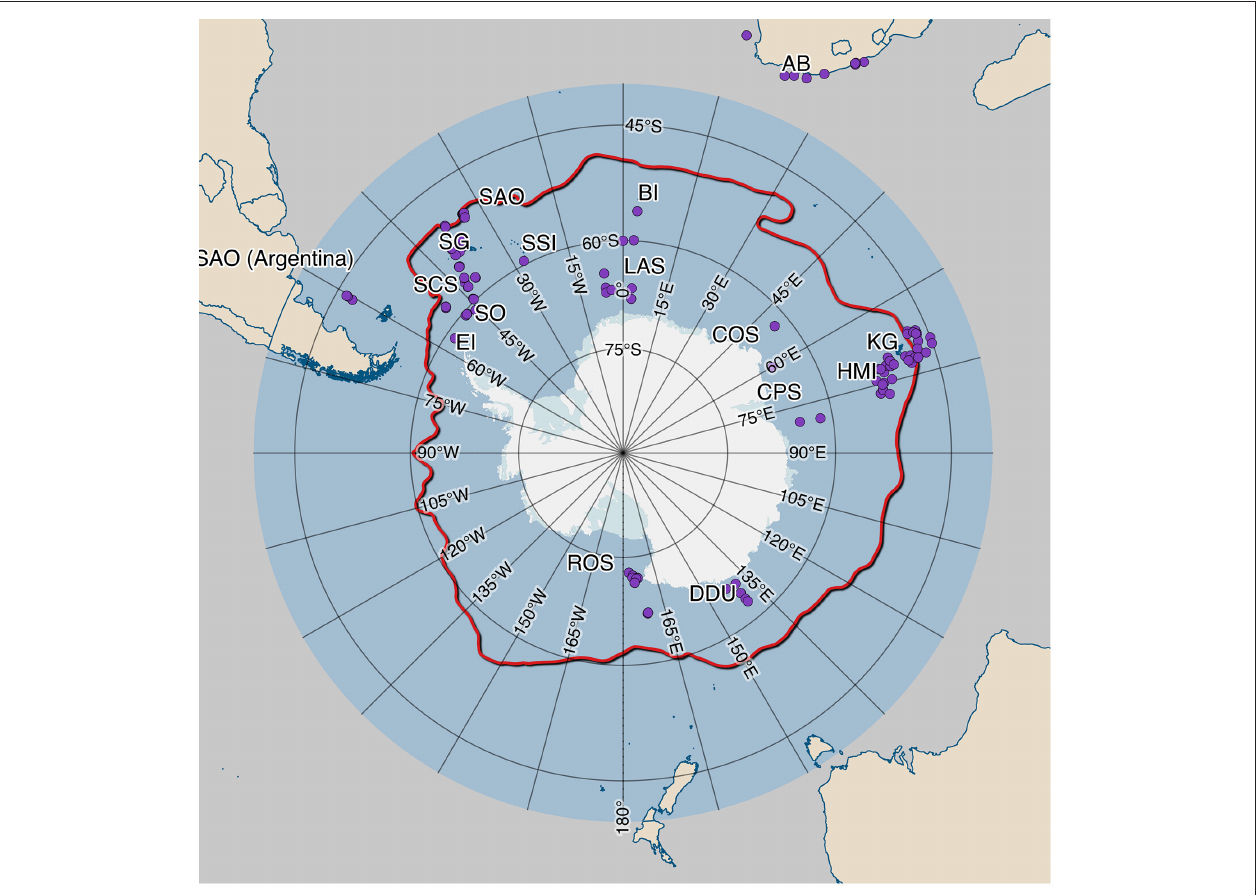
FIGURE 1 | Locations of mesopelagic fish sampled in the Southern Ocean and subsequently used for DNA barcoding. The bold, red line marks the approximate position of the Antarctic Polar Front. Location codes are (approx. clockwise from West to East Antarctic): SAO, South Atlantic Ocean; SCS, Scotia Sea; EI, Elephant Island; SO, South Orkney Islands; SG, South Georgia Islands; SSI, South Sandwich Islands; BI, Bouvet Island; LAS, Lazarev Sea; AB, Agulhas Bank (off South Africa); COS, Cosmonauts Sea; CPS, Cooperation Sea; KG, Kerguelen Islands; HMI, Heard and McDonald Islands; DDU, Dumont d’Urville Sea; ROS, Ross